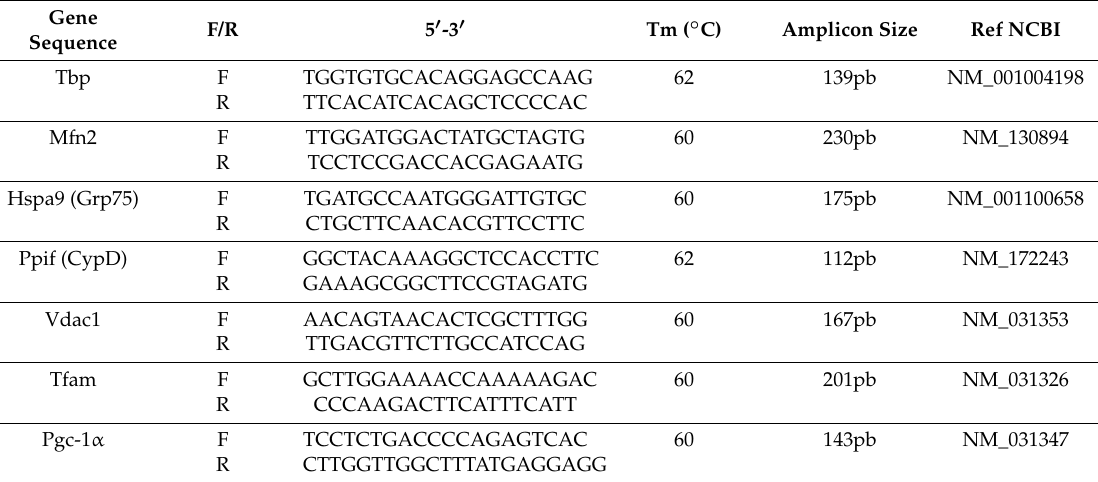
Table 1. Sequences of primers used for the RT-PCR